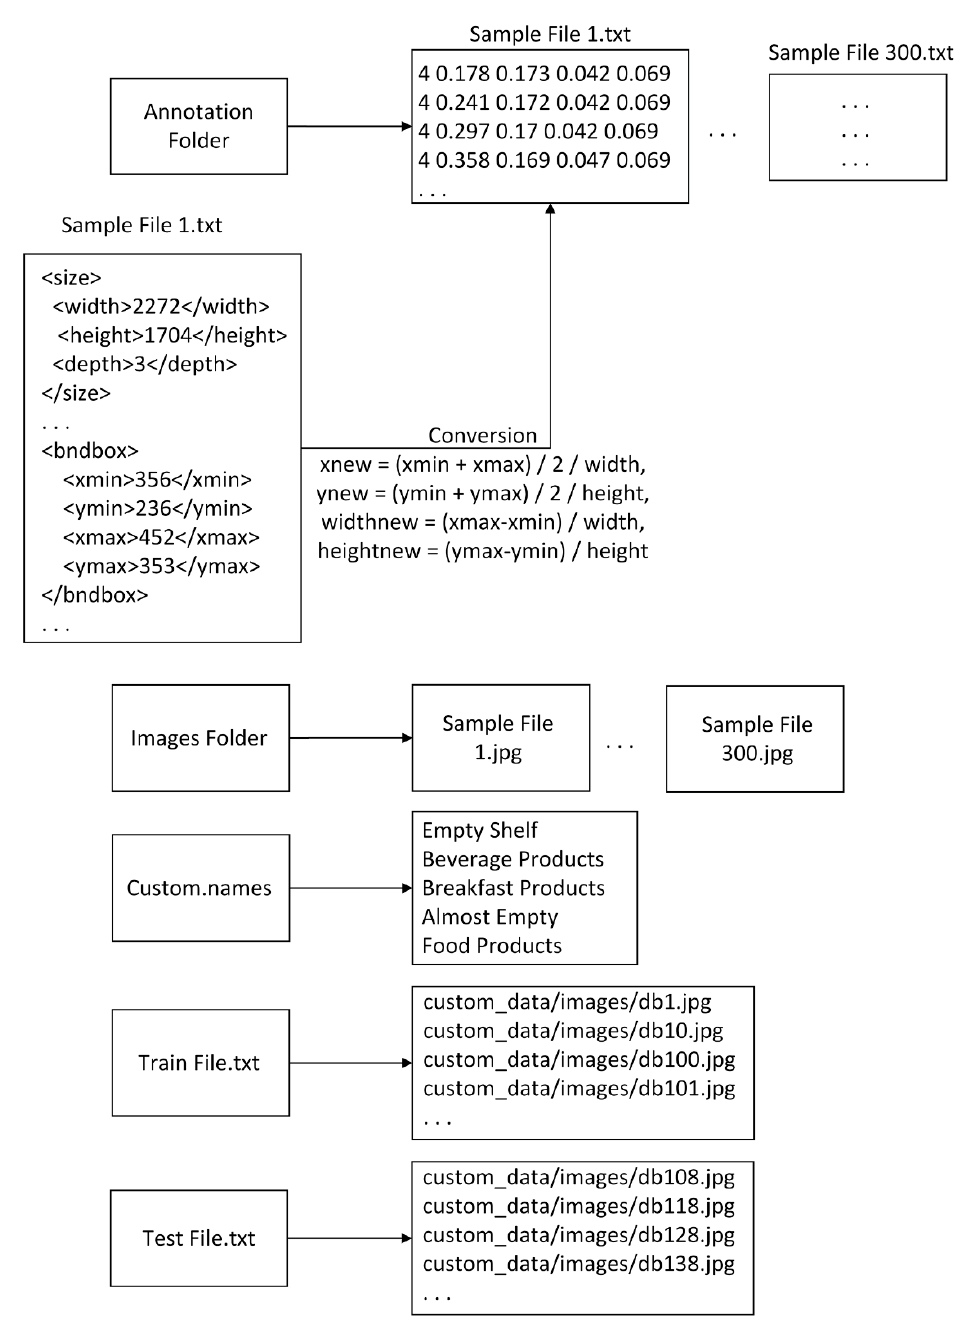
Figure 10. YOLOv3 and YOLOv4 sample file structure and conversion details.